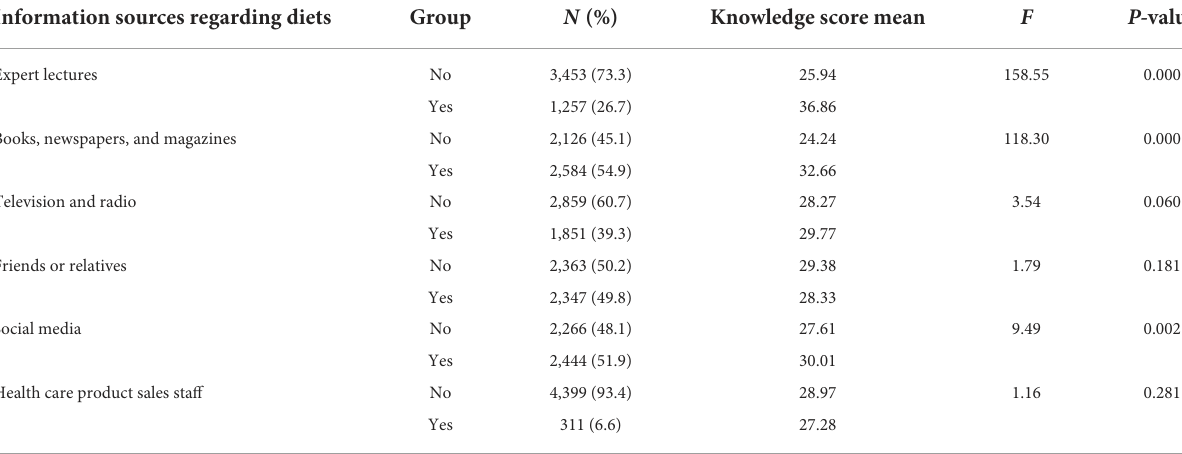
TABLE 3 Origin of information regarding diet and ANOVA analysis of knowledge of adequate diets score means among different information sources regarding diets ( N = 4,710). Information sources regarding